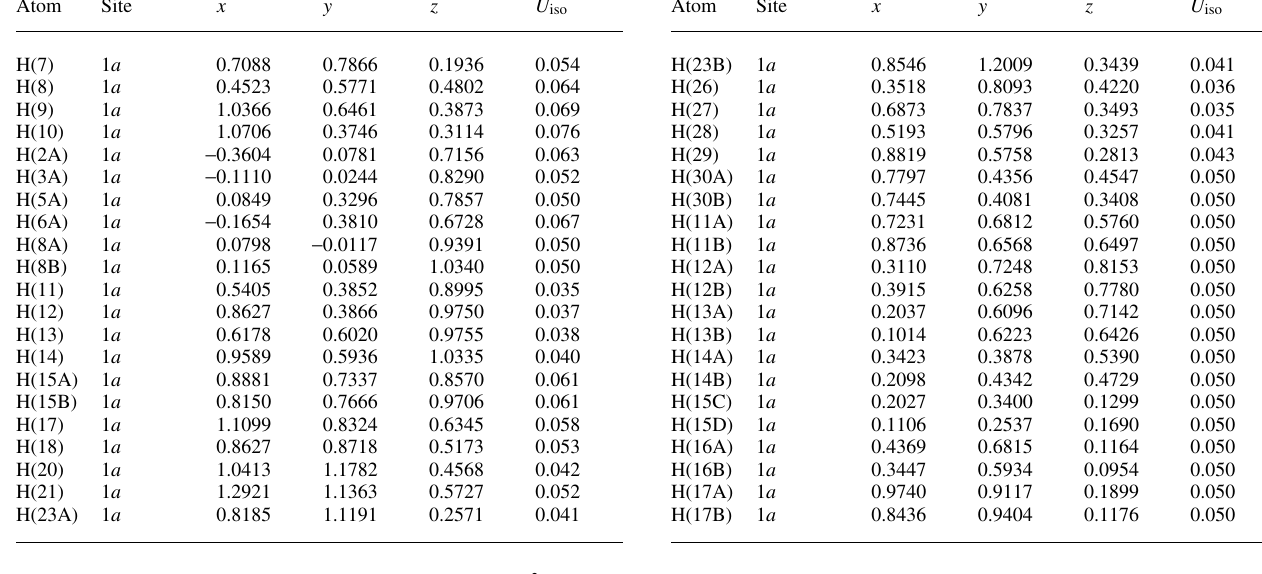
Table 3. Atomic coordinates and displacement parameters (in Å 2 )